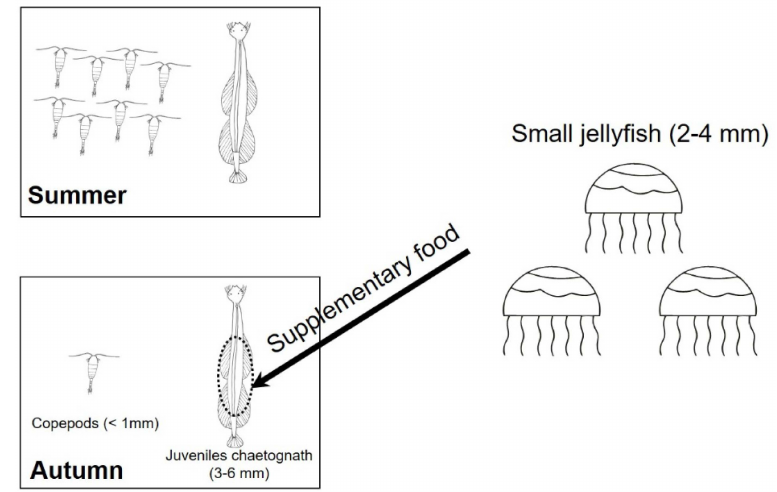
Figure 4. Schematic of the main food groups for juveniles chaetognath in Sanya Bay. (Copepods including copepod nauplii and copepodites; Small jellyfish could be fed by juveniles chaetognath in forms of planula, polyps, medusa and